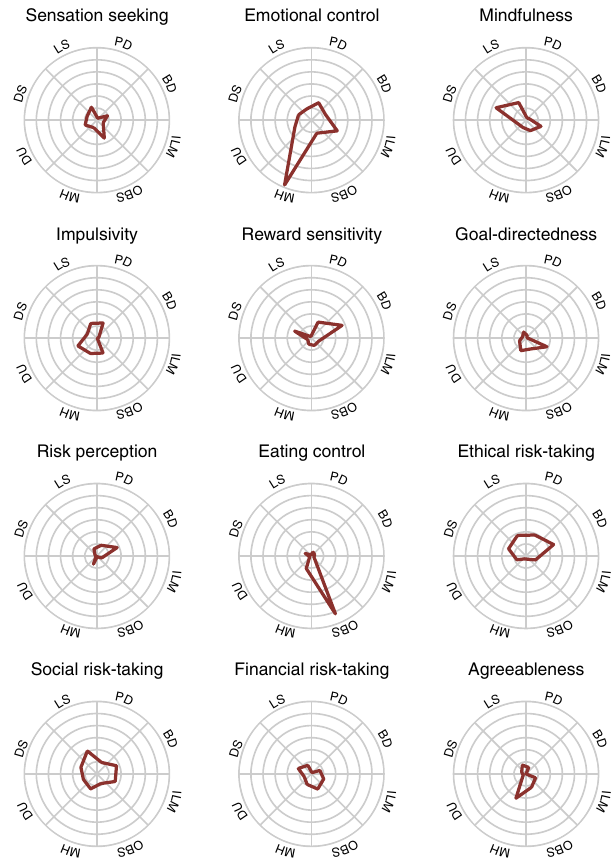
Fig. 8 Survey factor ontological fi ngerprints. Each polar plot represents the relationship of each survey factor with the 8 target outcomes. This relationship is de fi ned by the β value associated with that factor predicting that target outcome. For instance, the factor Eating Control is selectively predictive of obesity, and no other outcome. Unlike Figs. 6 and 7, the fi ngerprints all share the same y -axis (max value = 0.4) and thus can be compared across plots. For example, Impulsivity and Social Risk-Taking both contribute to the prediction of lifetime smoking, but the association with Social Risk-Taking is stronger. BD: binge drinking, PD: problem drinking, DU: drug use, LS: lifetime smoking, DS: daily smoking, MH: mental health, OBS: obesity, ILM: income/life